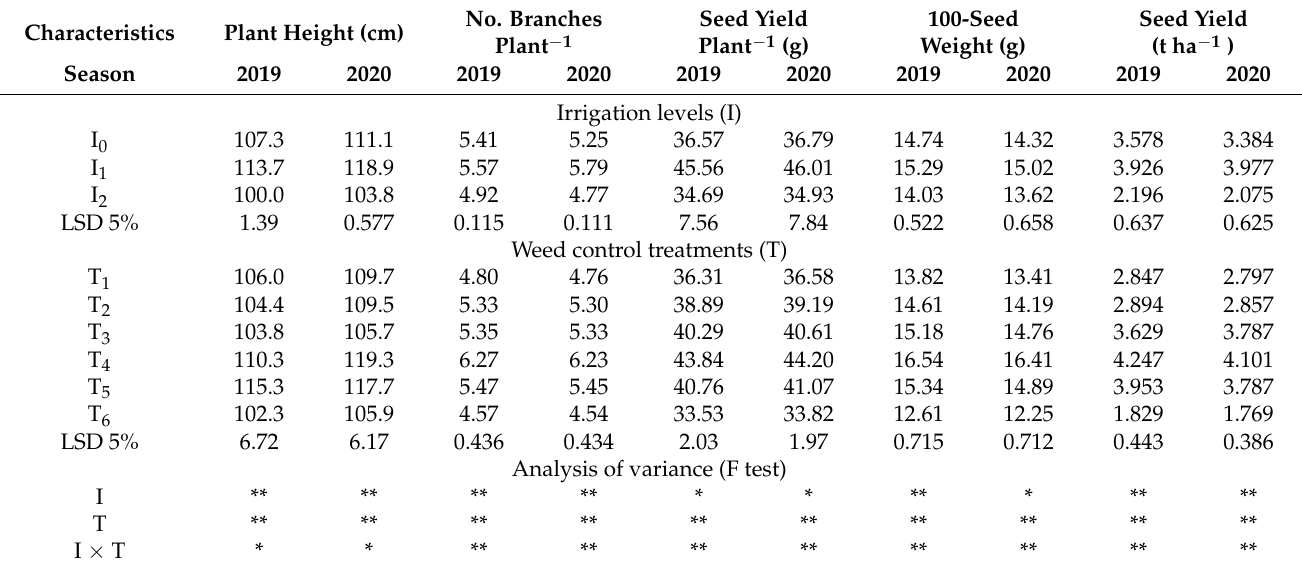
Table 8. Effect of irrigation levels and weed control treatments on yield and its components in the 2019 and 2020 seasons.